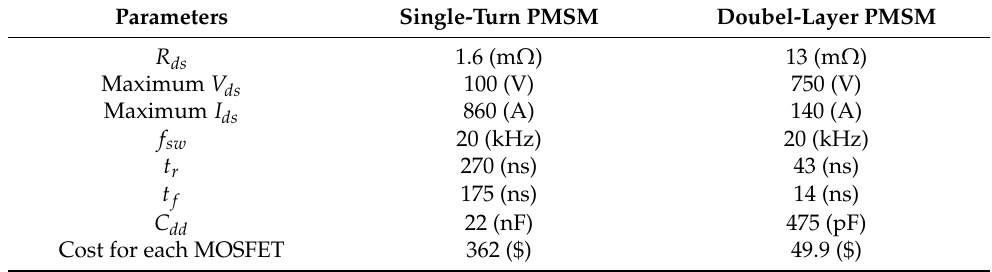
Table 4. Specifications for